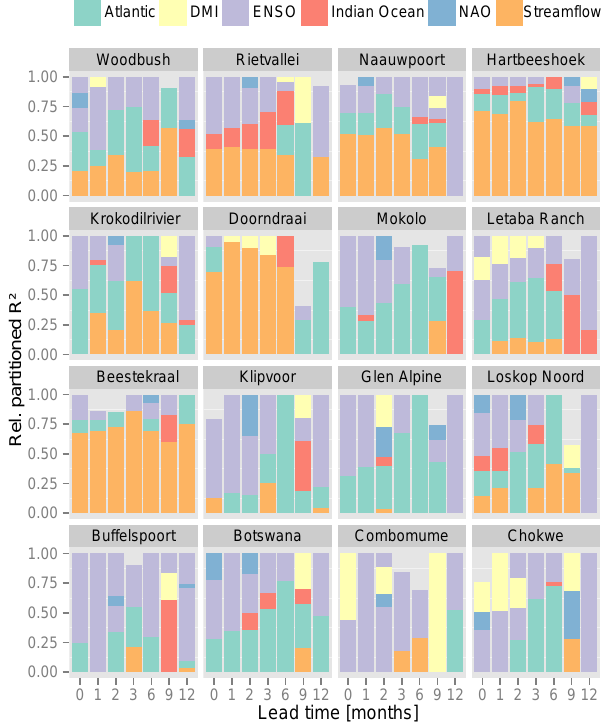
Figure 8. Relative partial R 2 by the predictors in the MLMs sum- marised as follows: antecedent streamflow conditions, Indian Ocean dipole mode index (DMI), El Niño–Southern Oscillation (ENSO) indices, North Atlantic Oscillation index (NAO) and the customised indices of the southern hemispheric Atlantic (Atlantic) and the In- dian Ocean (Indian Ocean). Parameter interactions are excluded from the plot and account for the white gaps. Stations are ordered by catchment area from small (top left) to large (bottom